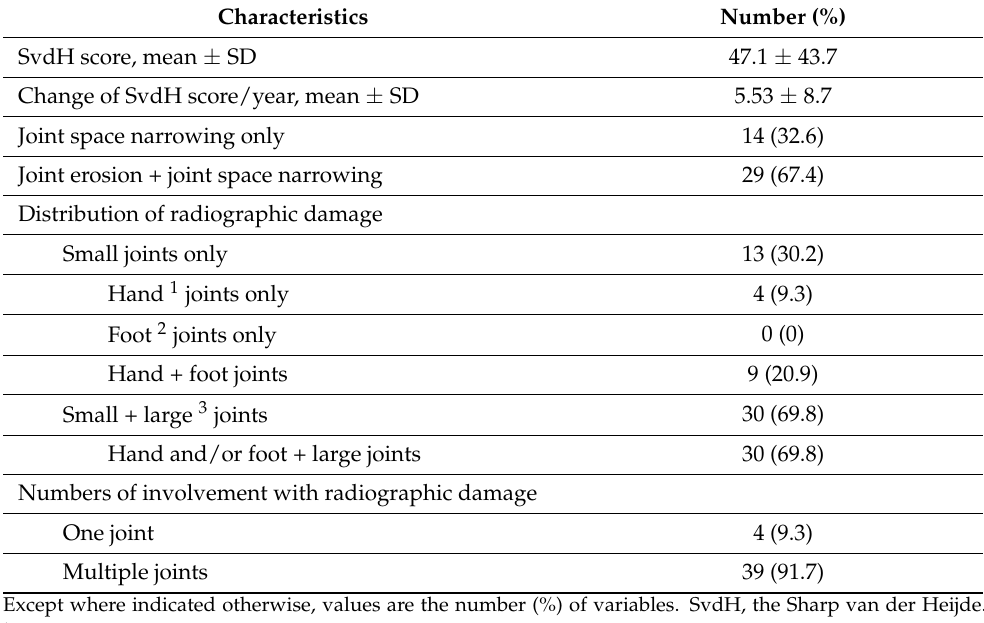
Table 2. Characteristics of seronegative rheumatoid arthritis (RA) patients with radiographic pro- gression during follow-up period (total number of patients = 43).